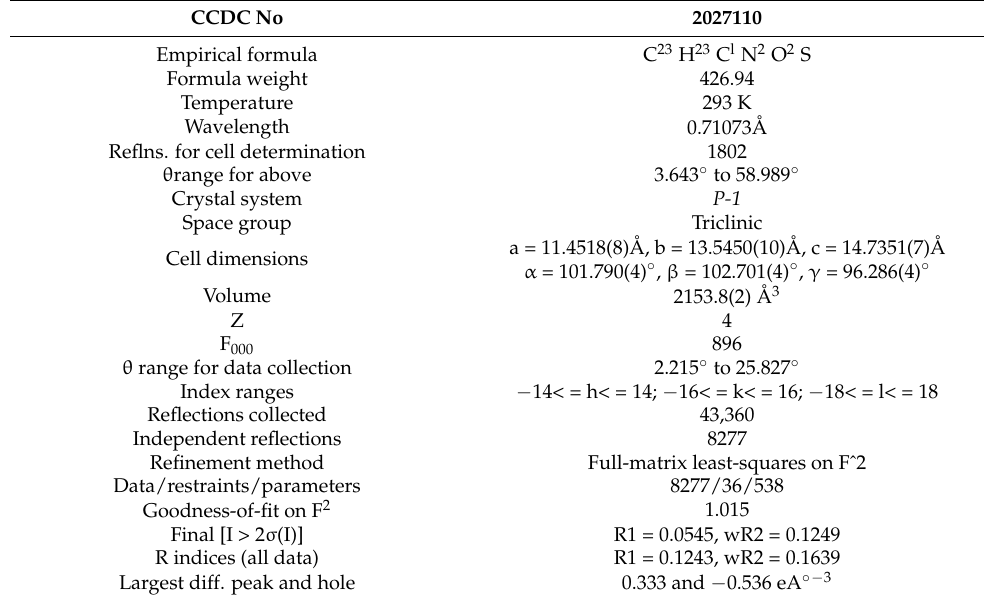
Table 2. Crystal data and structure refinement details of 4r